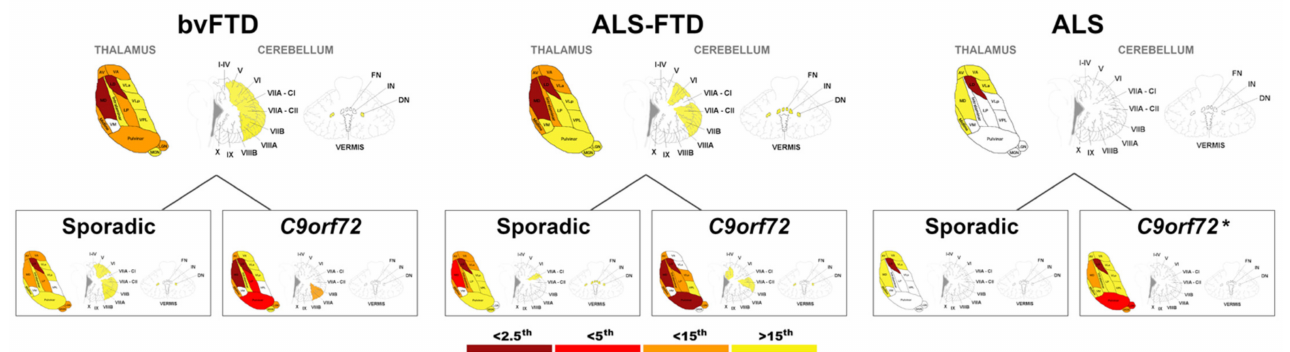
Figure 2. Pattern of neuroanatomical involvement in bvFTD, ALS–FTD and ALS groups, further di- vided by the sporadic form or presence of C9orf72 expansions. The colour map indicates the percentile corresponding to the average w-score in each patient group, when this was statistically negative when compared to controls. * Only two ALS patients carried a C9orf72 expansion, and the relative figure should be interpreted with caution. Abbreviations. Thalamus: AV—anteroventral,